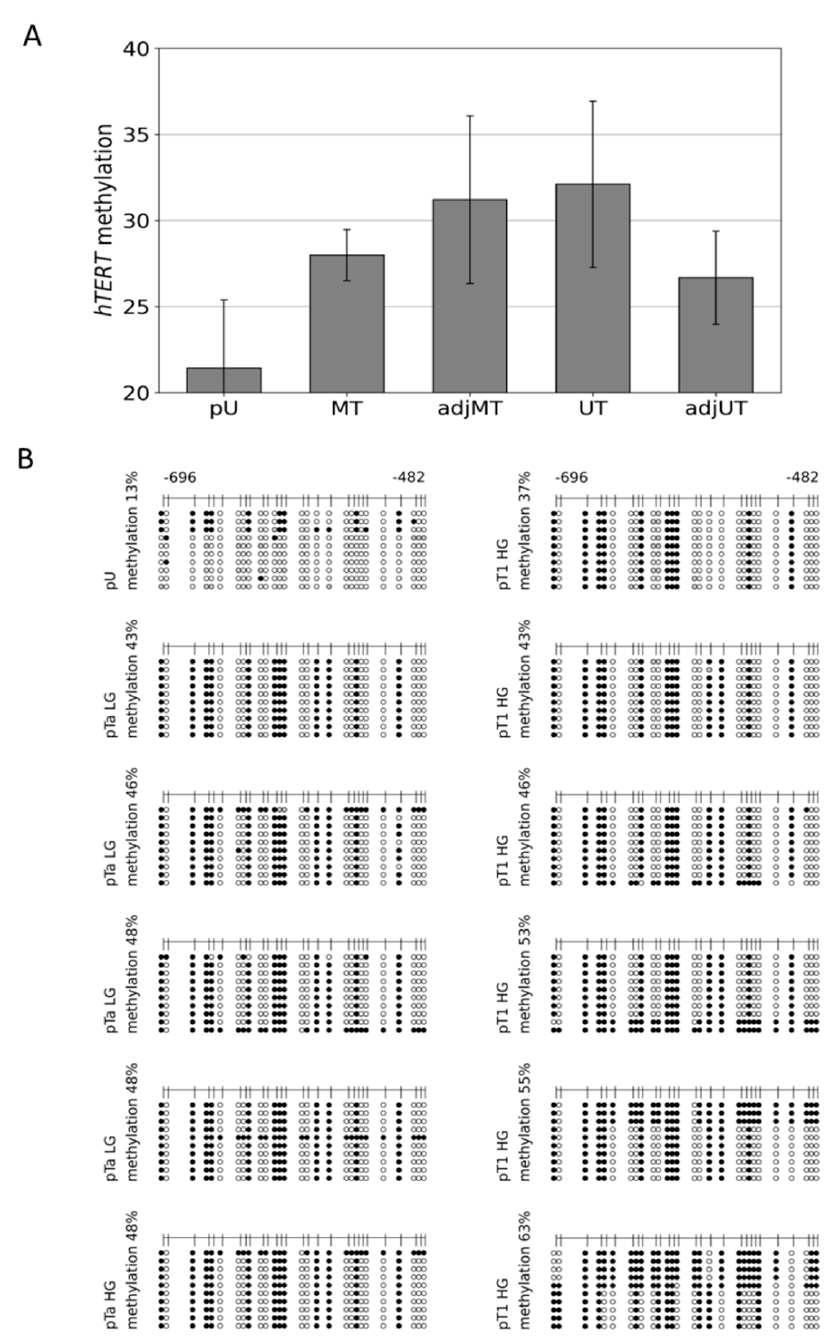
Figure 2. Mean peak values detected by microarray DNA methylation analysis of the THOR region at the 5 (cid:48) -region of the hTERT gene and detailed THOR methylation profiles of pTa LG/HG and pT1 HG urothelial cancer. Methylation grade by MeDIP/promoter array analyses: 4 primary urothelium (pU): 21.416, 5 multifocal tumors (MT): 27.992, 5 adjacent multifocal tumors (adj MT): 31.202, 10 unifocal tumors (UT): 32.099, and 4 adjacent unifocal tumors (adj UT): 26.671 ( A ). In addition, the detailed DNA methylation patterns of a 215 bp 5 (cid:48) -fragment within THOR, ranging from − 482 to − 696 relative to the translational start site of HTERT gene, were determined from 1 pU, 4 pTa LG, 1 pTa HG, and 6 pT1 HG urothelial cancer samples ( B ). Here, every unmethylated CpG dinucleotide is represented by a blank circle, every methylated one by a black circle, and non-determined CpG positions are depicted by grey